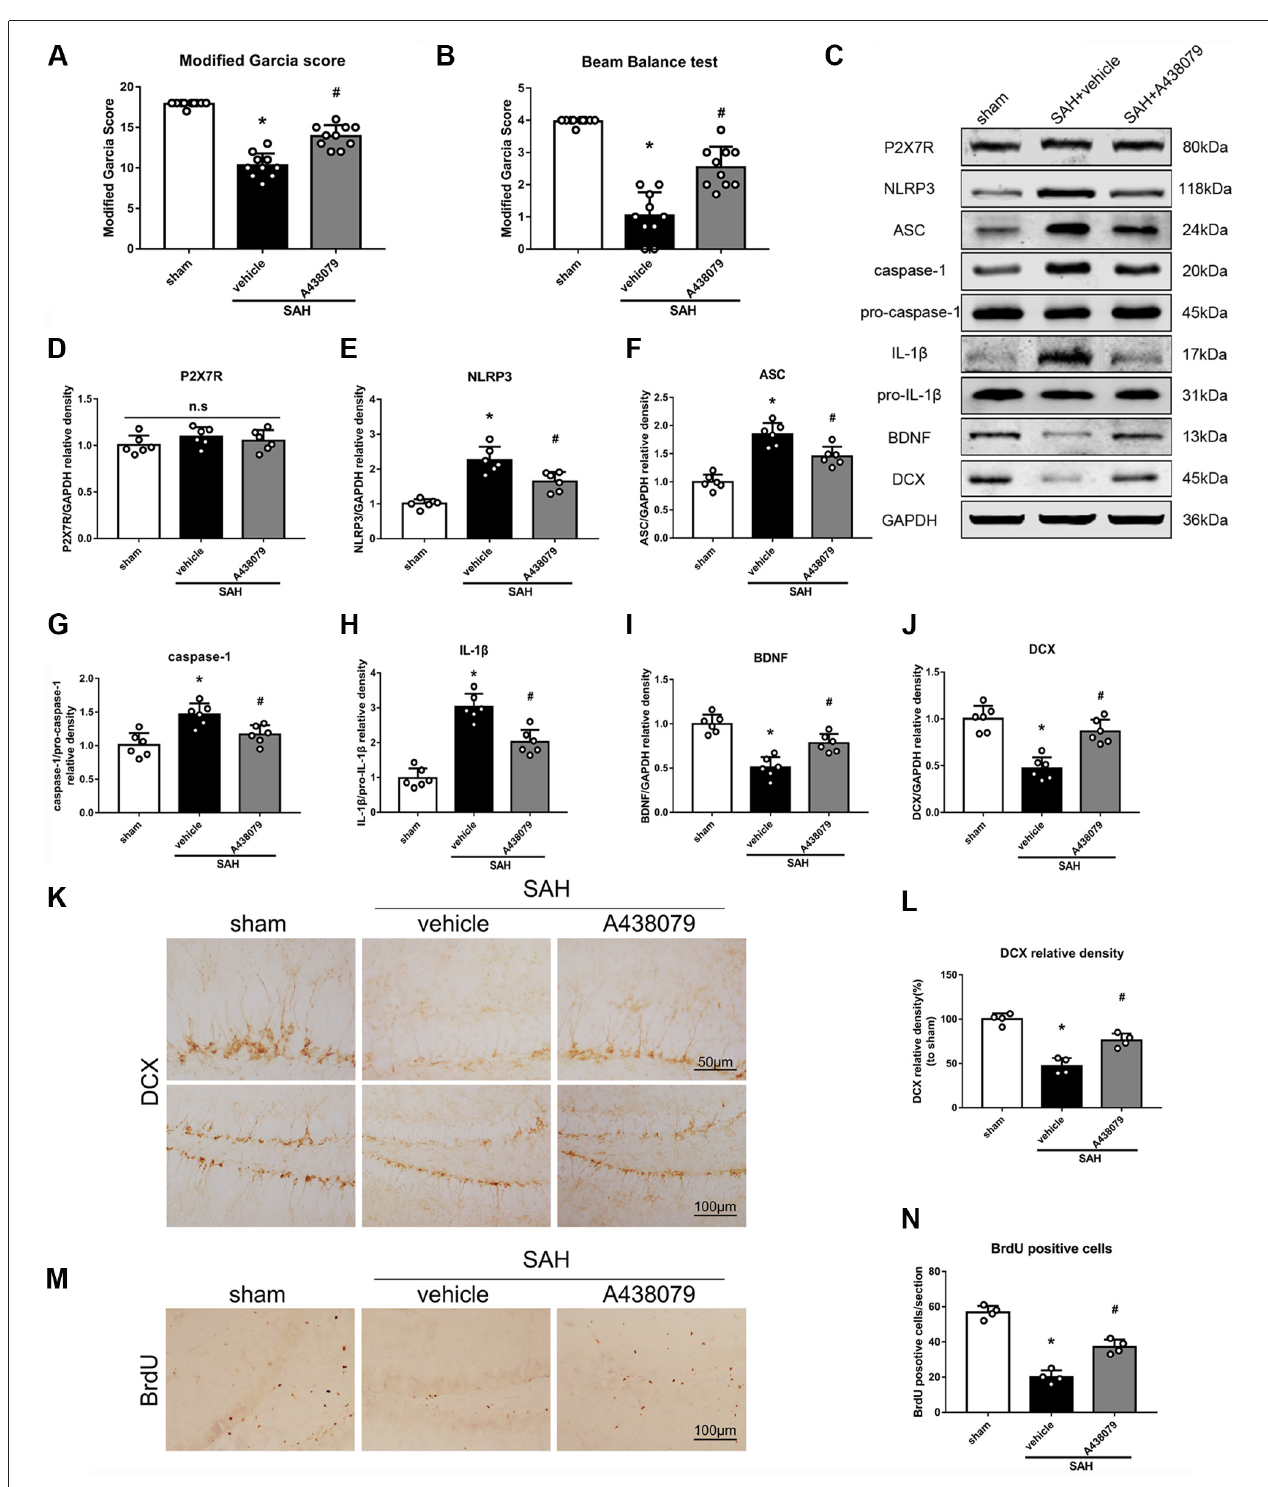
FIGURE 9 | Effects of A438079 on the SAH-induced signaling pathway and neurogenesis 48 h after SAH. (A) Modified Garcia scores and (B) beam balance test scores; n = 10 per group. (C) Representative western blots. (D–J) Quantitative analyses of P2X7R, NLRP3, ASC, caspase-1, IL-1 β , BDNF and DCX in the left hemisphere; n = 6 per group. (K) Immunohistochemistry staining and (L) quantitative analyses of DCX in the left hemisphere. (M) Immunohistochemistry staining and (N) quantitative analyses of BrdU in the left hemisphere; n = 4 per group. ns, no significant. ∗ P < 0.05 vs. sham; # P < 0.05 vs. SAH + vehicle. The error bars represent